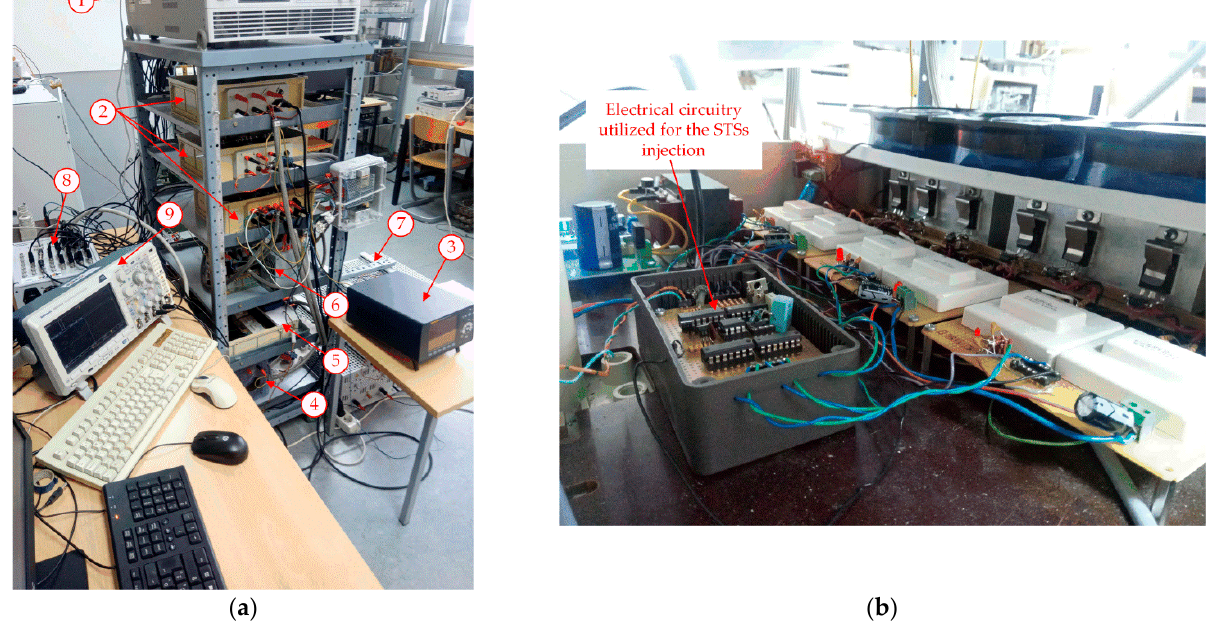
Figure 8. Laboratory setup of the qZSI in the stand-alone configuration ( a ), the qZSI three-phase inverter bridge ( b ).